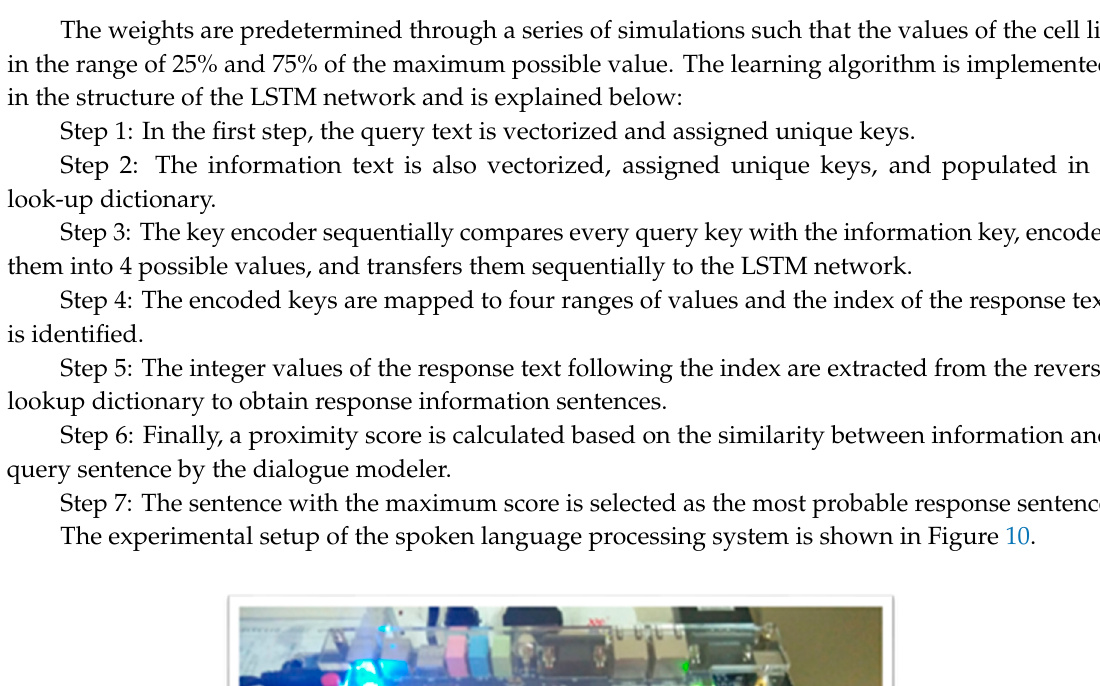
Figure 9. Main control unit of the language processor.